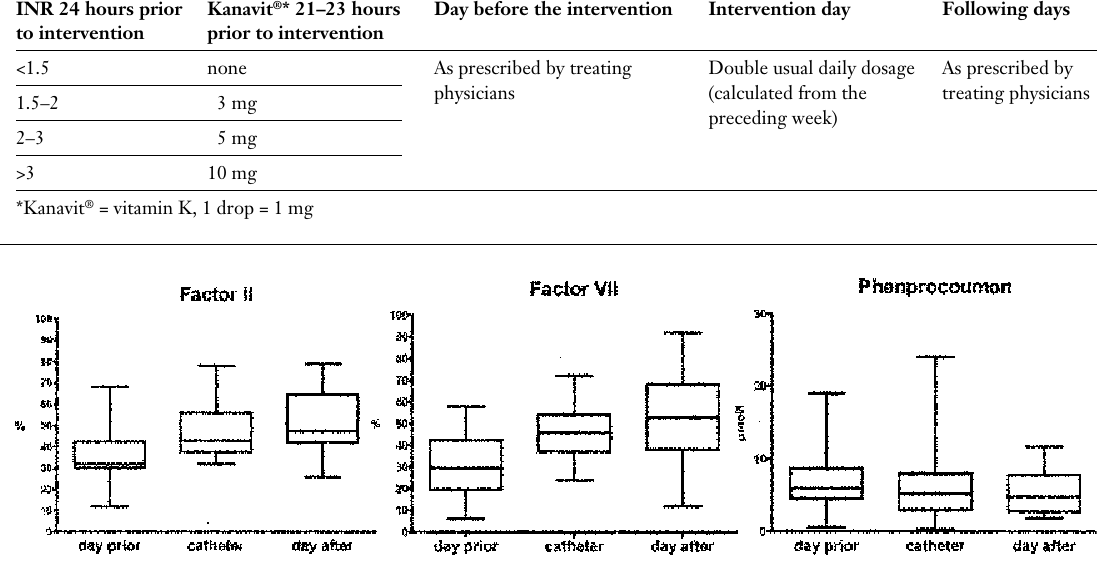
Temporal anti- coagulation reversal scheme to be vali- dated in the present study.